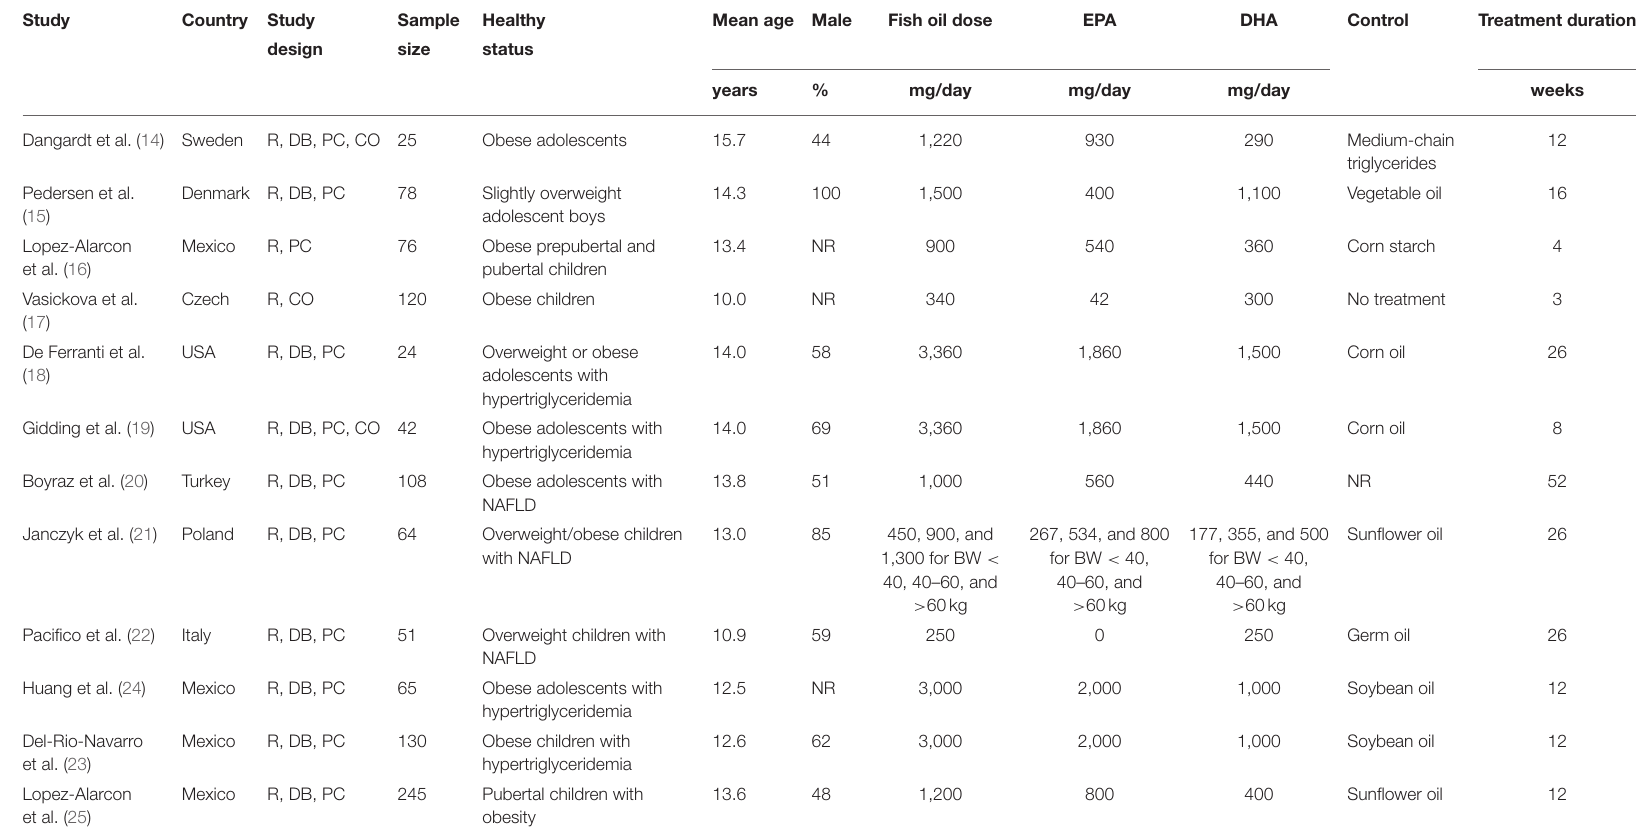
TABLE 1 | Characteristics of the included